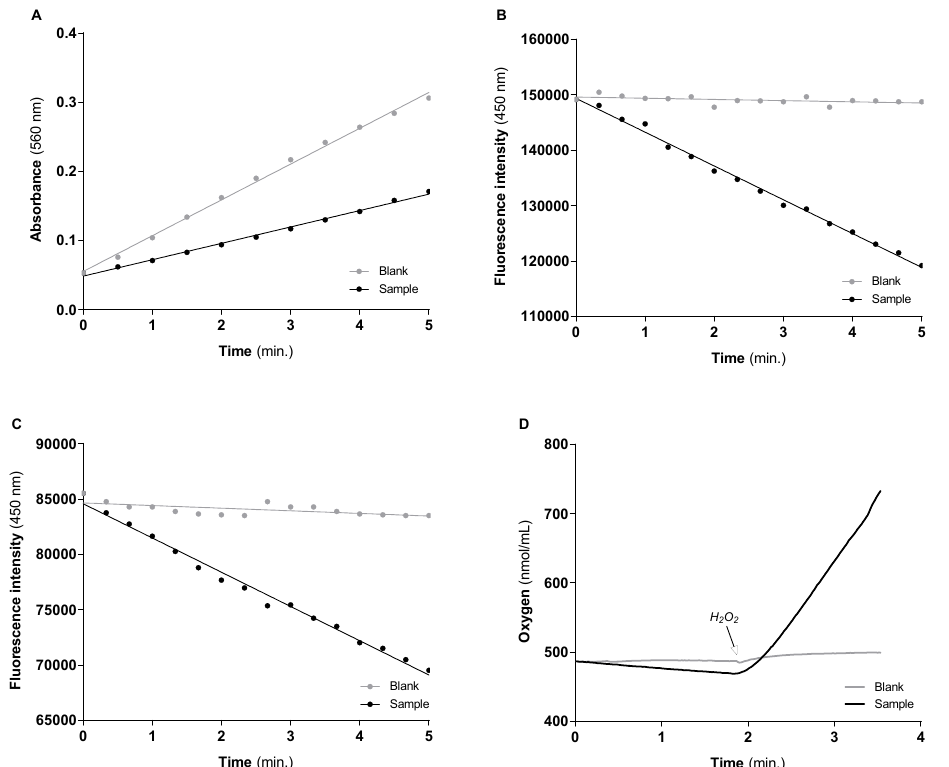
Figure 13. Typical progress curves were used to assess the activities of Cu/Zn-SOD ( A ), GR ( B ), GPx ( C ) and CAT ( D ) enzymes in the mitochondria-free cytosolic fraction. Enzyme activity is calculated by the difference (or module of the difference) between the slopes of the black lines (sample) and grey lines (blank). The “blank” conditions represent in: ( A ), the detection of the O 2 •− produced by xanthine/xanthine oxidase system in the absence of mitochondria-free cytosolic fraction; ( B ), NADPH oxidation in the absence of GSSG; ( C ), NADPH oxidation in the absence of GSH and presence of GR enzyme; ( D ), oxygen production induced by H 2 O 2 addition in the absence of the biological sample. Table 11. Typical linear regressions of cytosolic antioxidant enzymes obtained in assays with 50 µg of protein under “blank” and “sample” conditions (Figure 13) and the calculated enzyme activity.